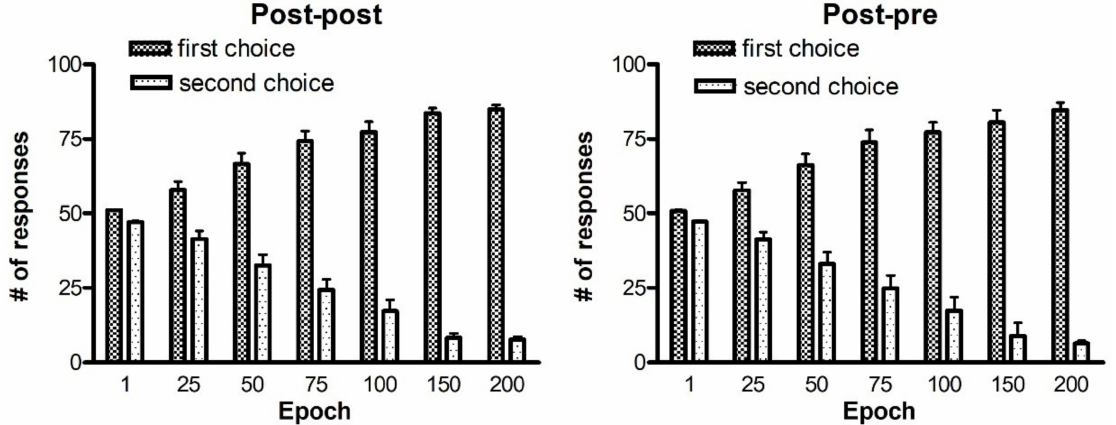
Figure 2. This figure shows the capacity to perform the task correctly (i.e., to select the more correct response, that is the first choice), as a function of the duration of the previous training. The meaning is the same as in Figure 1. (the bars represent mean values and standard deviation on 10 independent learning procedures), but the 100 test trials were performed using the synapse values obtained after different epochs of training. The left panel refers to the post-post rule, the right panel to the post-pre